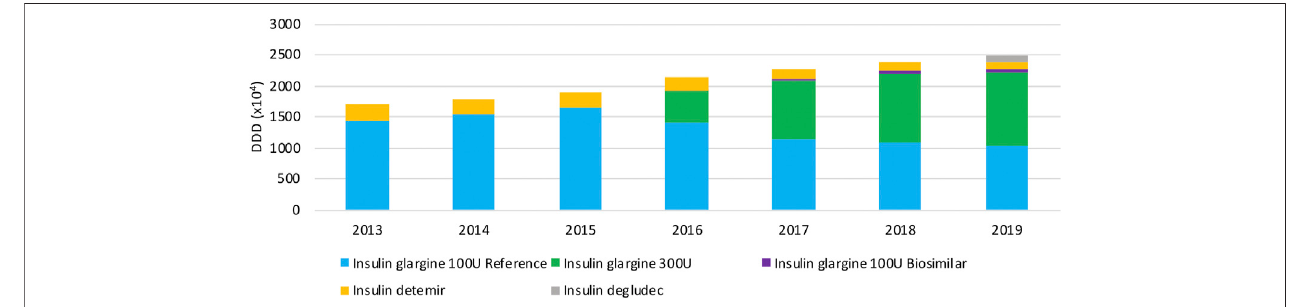
FIGURE 5 | Total volume (DDD) evolution of long-acting insulins between 2013 and